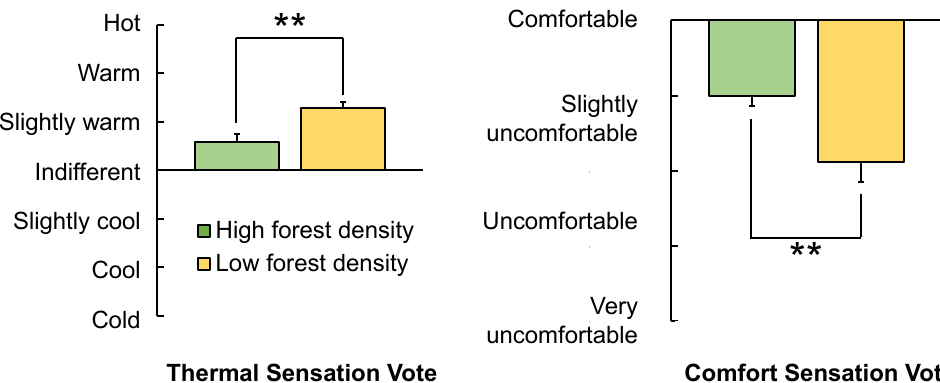
Figure 13. Comparison of thermal sensation vote (TSV) and comfort sensation vote (CSV) scores in the “after exercise” between high forest density and low forest density. Changes in the personal sensations of “Thermal” and “Comfort”. N = 18, mean ± standard error. ** p < 0.01 using the Wil ‐ coxon signed ‐ rank test.